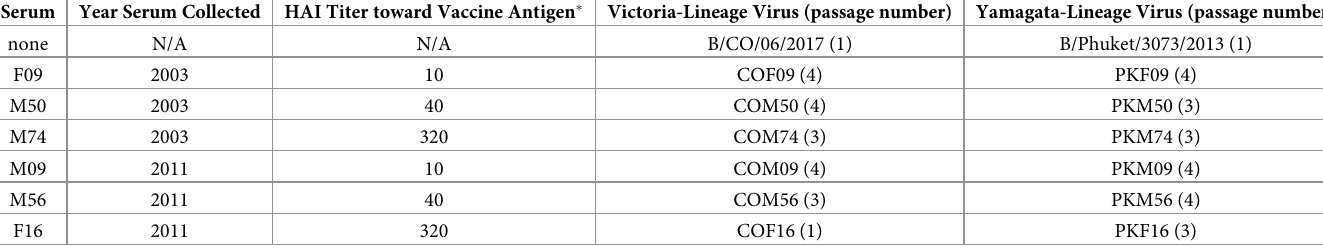
Table 1. Names of viruses and